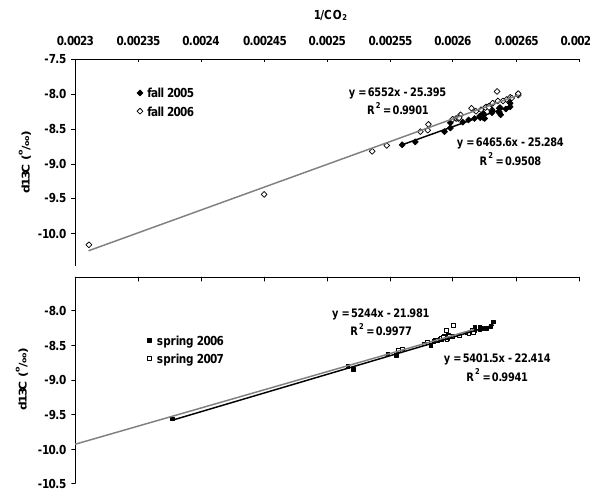
Fig. 1. δ 13 C vs. 1/CO 2 (“Keeling plot” e.g. Keeling, 1961) in flask samples collected at Paramaribo for the different measurement cam- paigns. The equation of the linear regression and its R 2 value is written next to the regression